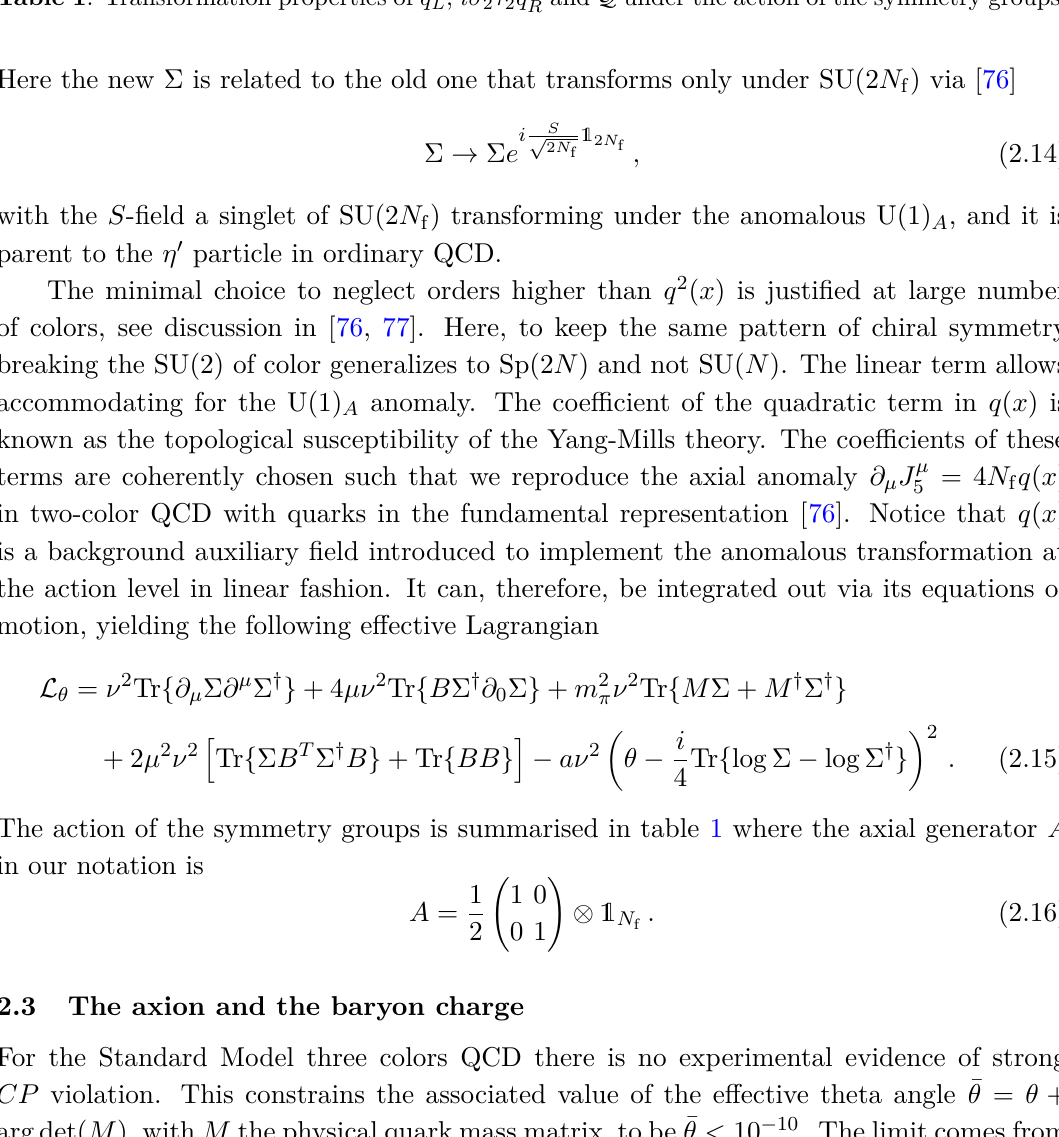
and Q under the action of the symmetry groups. R